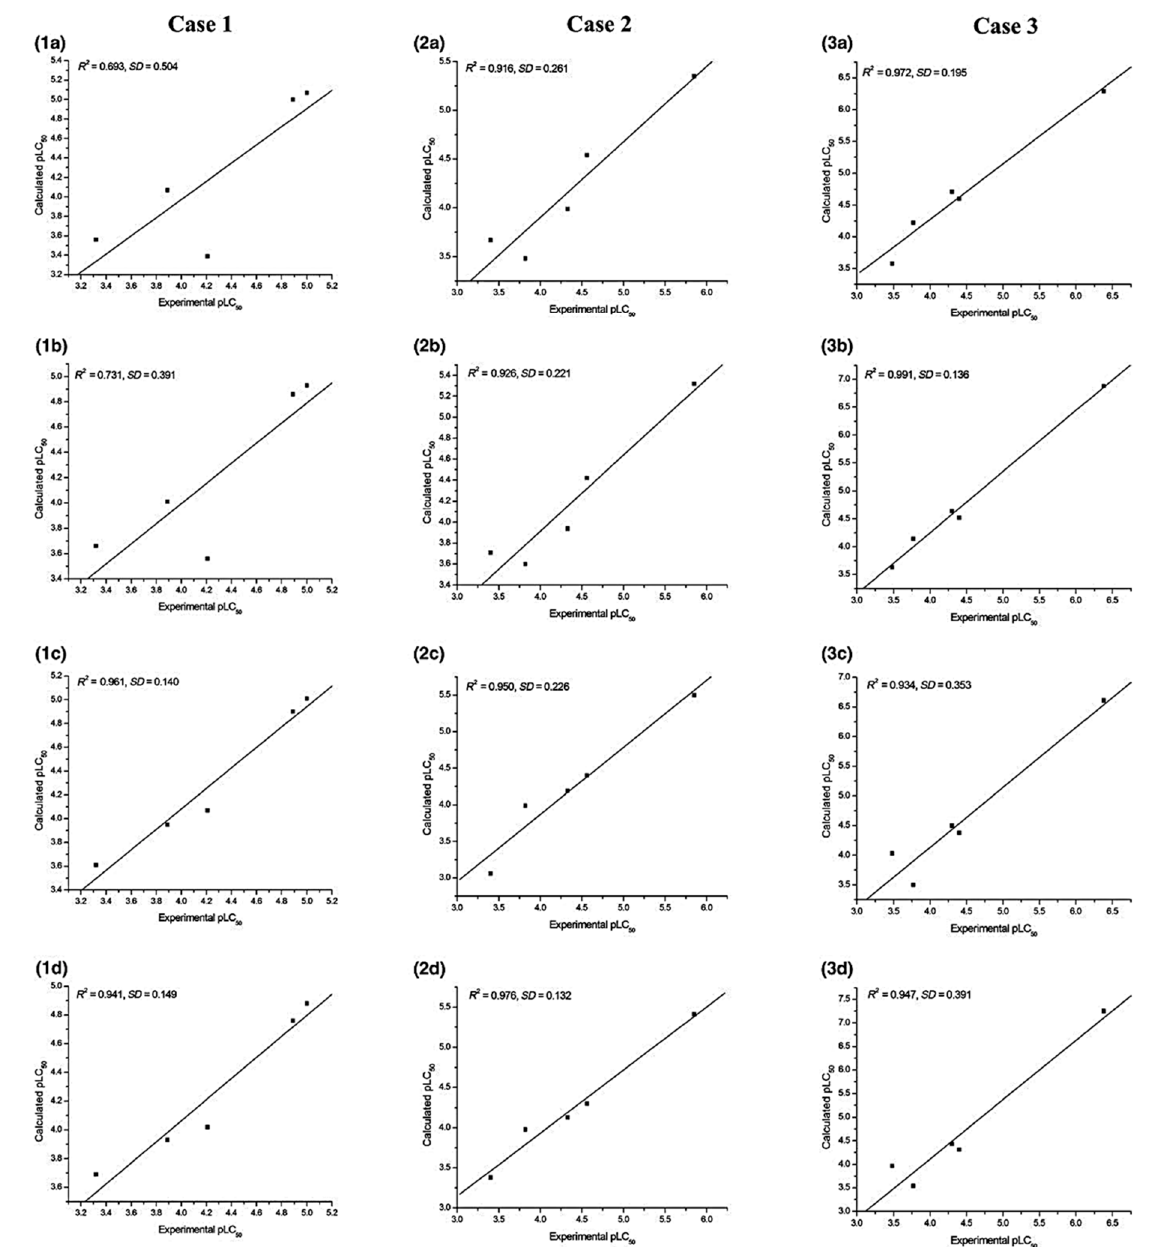
Figure 2. Experimental vs. calculated pLC 50 plots with respect to ( a ) ω , ( b ) ω 2 , ( c ) log P , and ( d ) (log P ) 2 , for the test set with regression models developed using the training set in all three cases of the three-fold CV (reprinted from ref. [56] with permission from John Wiley & Sons. © 2018 John Wiley & Sons